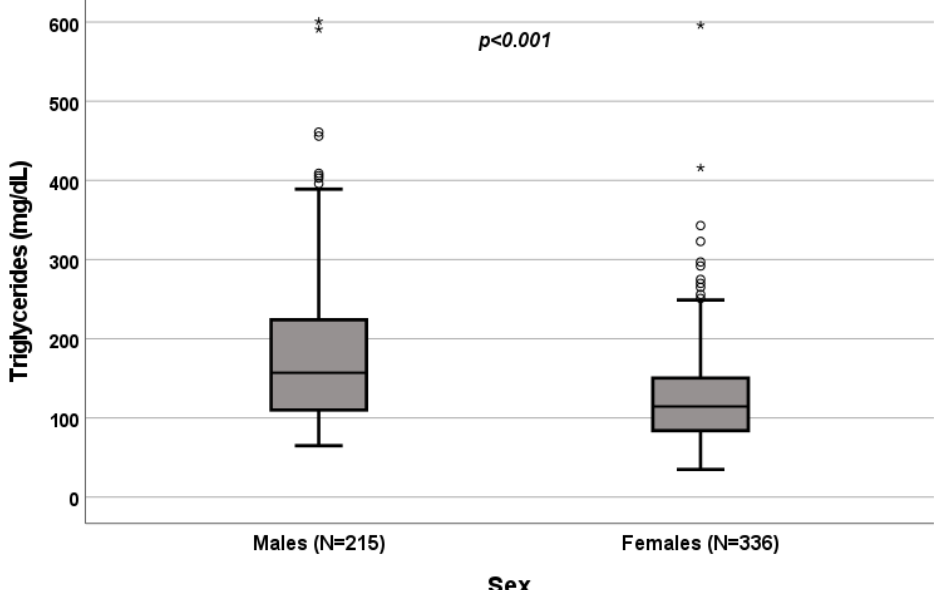
Figure 3. Influence of sex on triglyceride levels (mg/dL). Box plot of sex ’s influence on triglyceride levels (mg/dL): The black lines in the boxes show the interquartile ranges (IQRs): quartile 1, median values and quartile 3; the open dots and stars describe the outlier values. The P -value is shown.